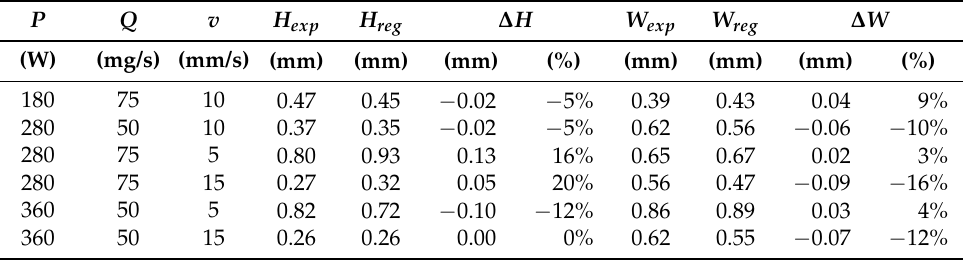
Table 4. Track dimensions predicted by the regression model and comparison with experimental data.